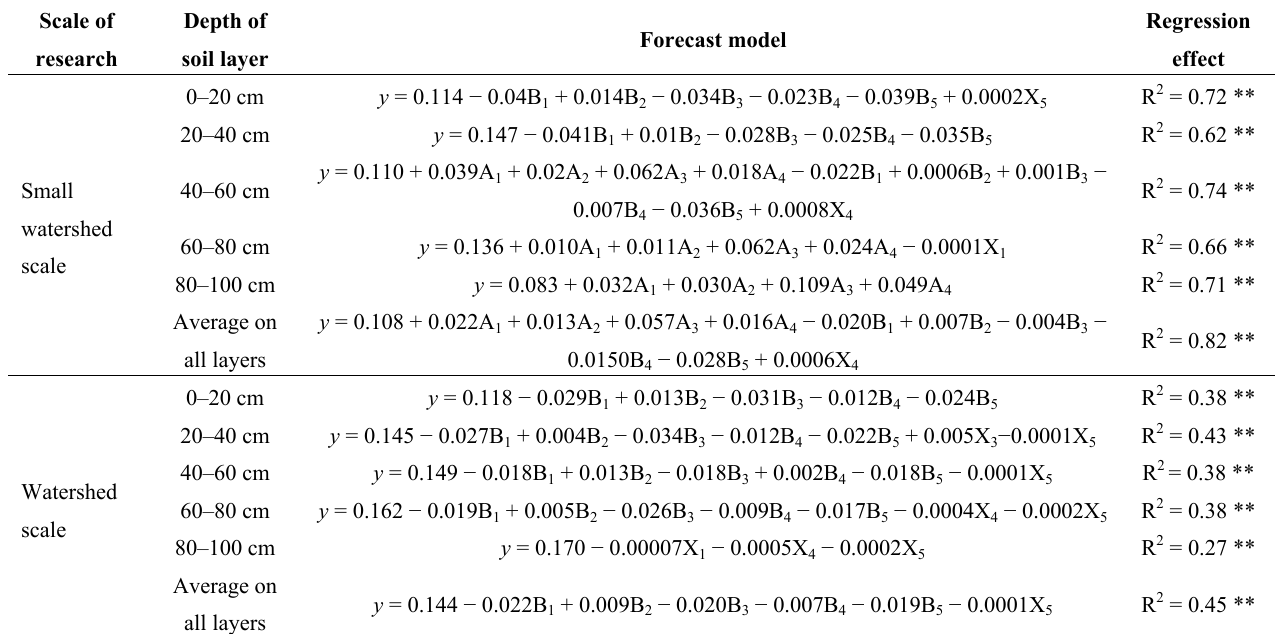
Table 6 . Stepwise regression model of environmental factors and soil